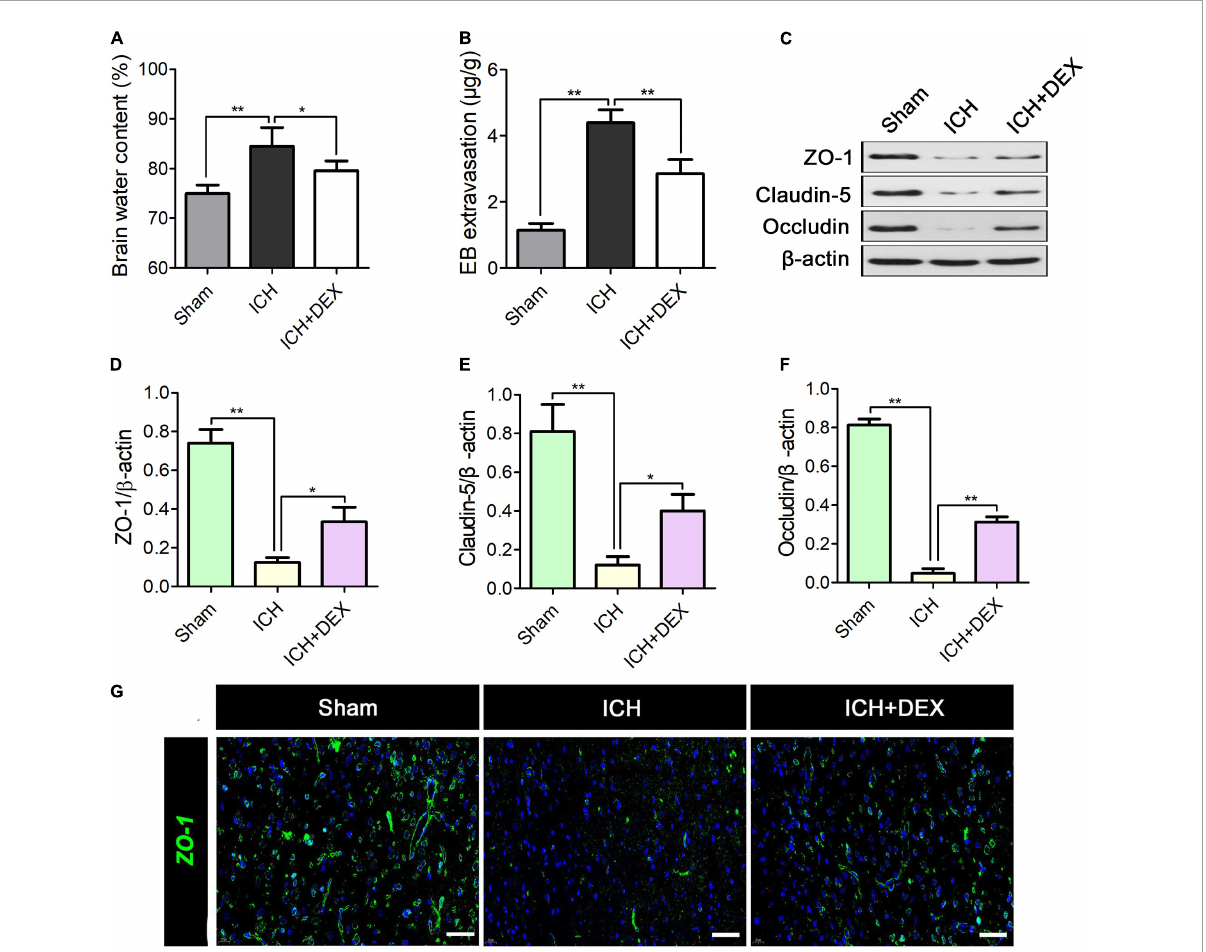
FIGURE3 On the 3rd-day post-ICH, (A) quantitative analysis of brain water content and (B) Evan’s blue analysis. (C) Representative Western blot expressions of ZO-1, occludin, and claudin-5. (D–F) Reduced levels of ZO-1, occludin, and claudin-5 was observed in the ICH group compared with the Sham group. However, the levels of the ZO-1, occludin, and claudin-5 increased in DEX group. (G) Immunofluorescence analysis showed similar results for the expression of ZO-1. * p < 0.05, ** p < 0.01. Scale bar = 50 µ